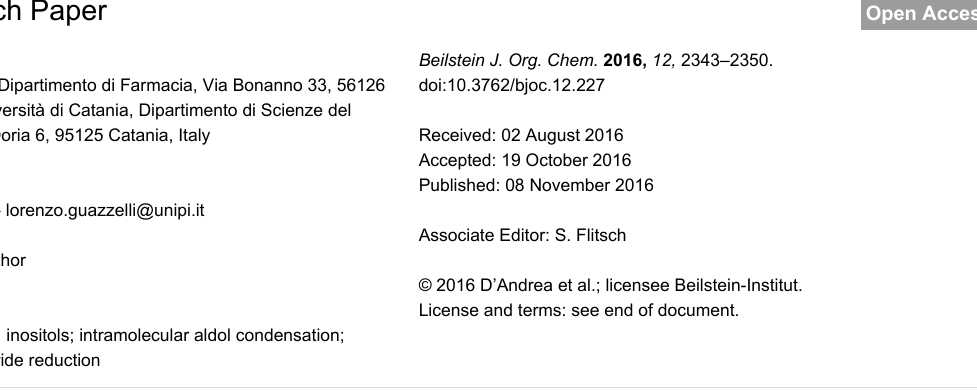
(Figure 1): five have been found in nature ( myo , scyllo , D-chiro , L-chiro , and neo ), while the remaining four are unnatural syn- thetic products ( cis , epi , allo , and muco